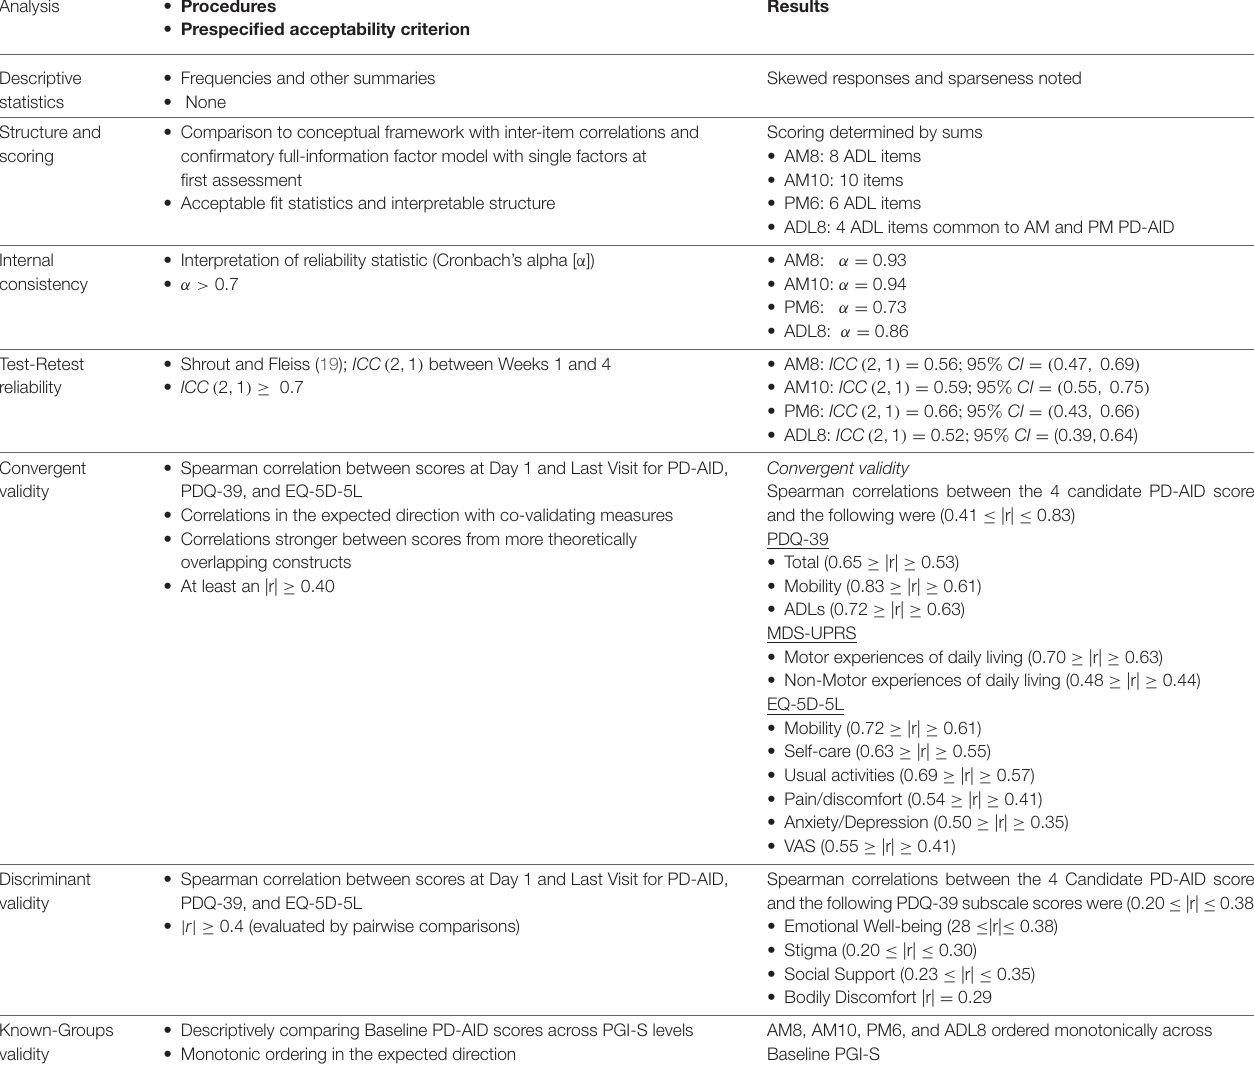
TABLE 4 | Psychometric